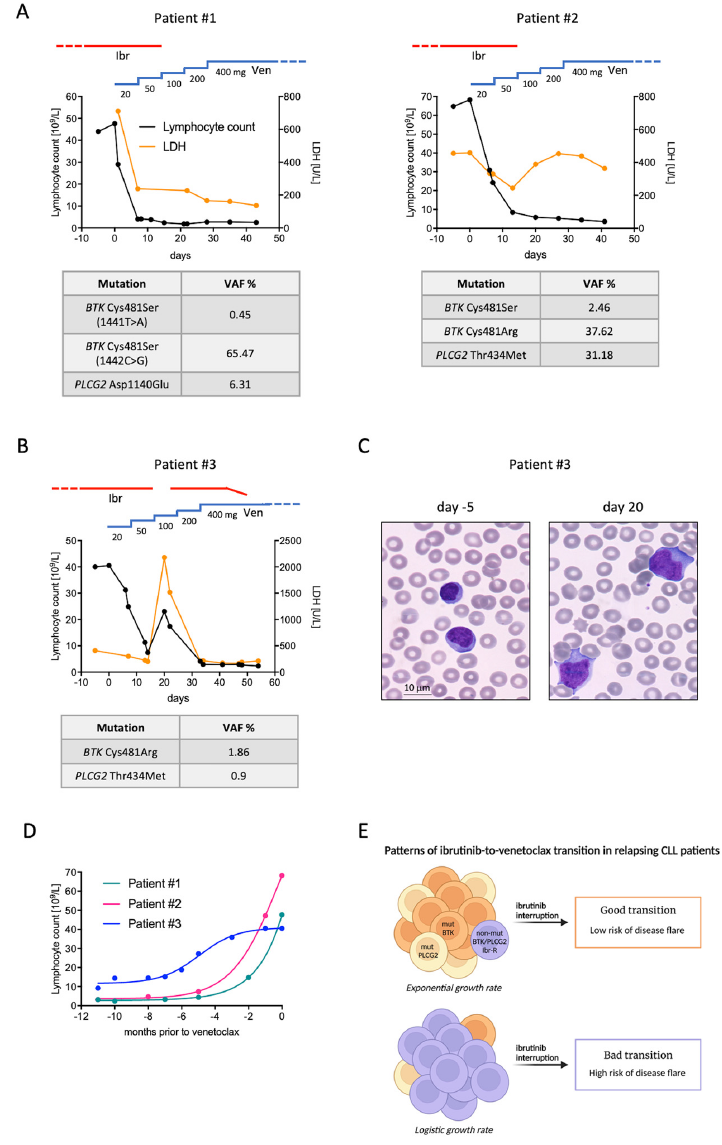
Figure 1. Clinical patterns of ibrutinib-to-venetoclax transition. ( A ) Lymphocyte count (black line), LDH values (orange line), and mutational analyses of patients undergoing the favorable transition pattern. ( B ) Lymphocyte count, LDH values, and mutational analysis of the patient undergoing the unfavorable transition pattern. ( C ) Peripheral blood smears (magnification 100 × ) of patient number #3 collected either before venetoclax initiation (while relapsing on ibrutinib, left panel) and after ibrutinib interruption (right panel). Small, mature lymphocytes were replaced by large cells with abundant basophilic cytoplasm and inconspicuous nucleoli. ( D ) Lymphocyte growth patterns of ibrutinib-relapsing patients described in this report. While patients #1 and #2 displayed an exponential growth rate, patient #3 showed a logistic growth pattern. ( E ) Working hypothesis resulting from ibrutinib-relapsing patients reported herein. Cases characterized by a high burden of BTK or PLCG2 mutations display an exponential growth rate, but carry a relatively low risk of disease flare after ibrutinib interruption (good transition). Contrarily, those with a low level of BTK and PLCG2 mutations show a more indolent relapse course and might continue to benefit from BTK inhibition. In these cases, ibrutinib interruption acutely restores the BTK signaling cascade, thus exposing patients to a higher risk of disease flare (bad transition). Ibr, ibrutinib; Ven, venetoclax; VAF, variant allele frequency; non-mut BTK/PLCG2 Ibr-R, ibrutinib-resistant cell without BTK/PLCG2